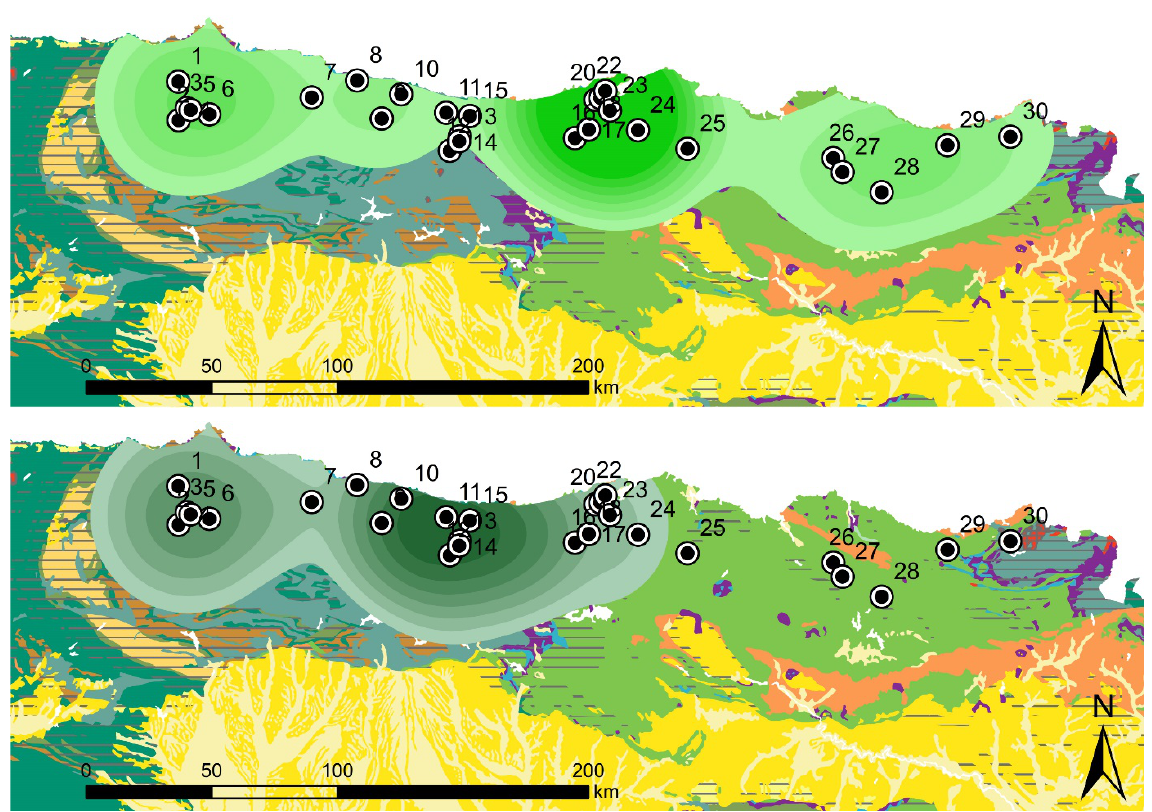
Figure 4. Kernel density of flint (above) and quartzite (below). Intense green on each map displays a higher density of flint or quartzite. Main chrono-lithological strata in the Cantabrian Region are displayed, based on a 1:1.000.000 geological map (Álvaro et al. 1994). Lithology colours are the same as in Figure 1. The numbers of the different archaeological sites are also the same as in Figure